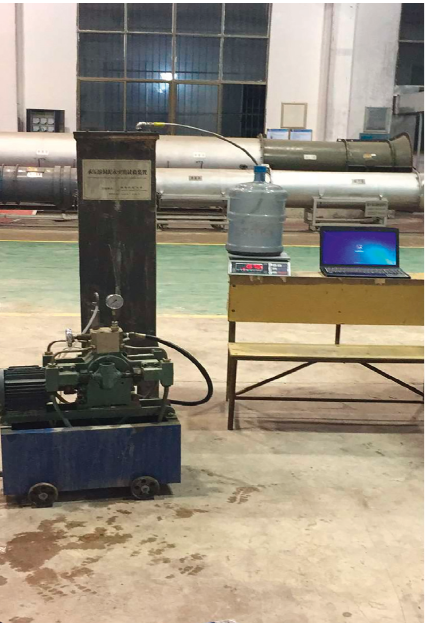
Figure 6: Test device of mud-water inrush through rock fractures.